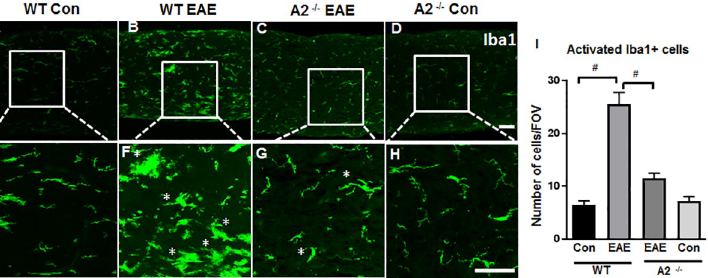
Fig 2. EAE-induced microglial/macrophage activation is ameliorated in the optic nerve of A2 knockout mice. A-D) Immunofluorescence images of Iba1 labeled optic nerve sections showing increases in cells with activated morphology in response to EAE induction. The deletion of A2 significantly reduced this effect. E-H) Magnified images of the boxed regions demonstrate changes in the morphology of Iba1 positive cells and the effects of A2 deletion. Asterisks indicate Iba1 positive cells with activated morphology following EAE induction. I) Quantification of Iba1 positive cells with activated morphology. Data are presented as Mean ± SEM. #p < 0.01 WT EAE vs WT Con and # p < 0.01 A2 -/- EAE vs WT EAE. Number of animals used: 8(WT Control);12 (WT EAE); 9 (A2 -/- EAE); 7 (A2 -/- Control). Representative images are presented. Scale bar 50 μ m.